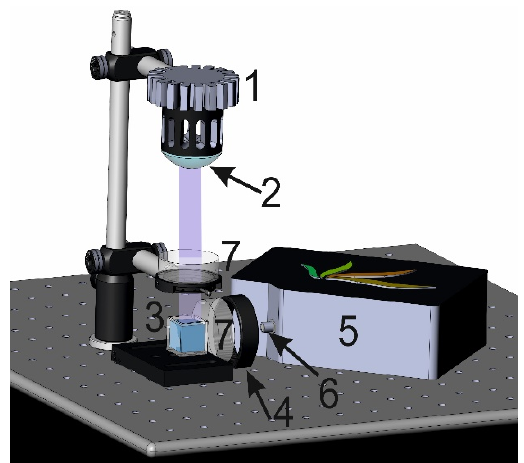
Figure 2. The laboratory set-up for the investigation of the LIF spectra of oil product solutions.